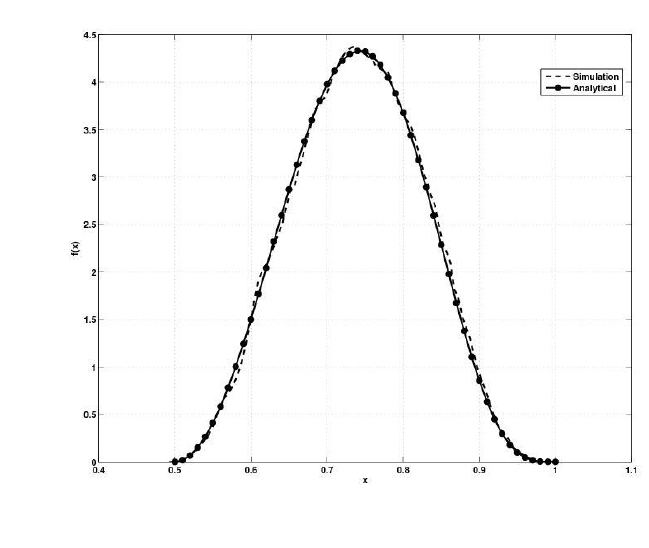
Figure 9. The PDF of the ratio of the largest eigenvalue to the trace of a correlated dual complex Wishart matrix.